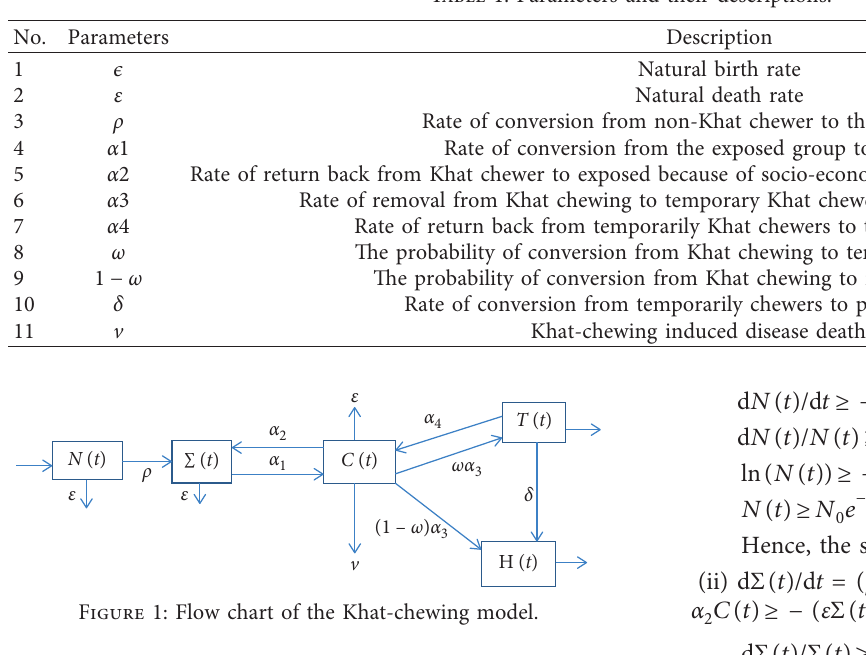
Table 1: Parameters and their descriptions.